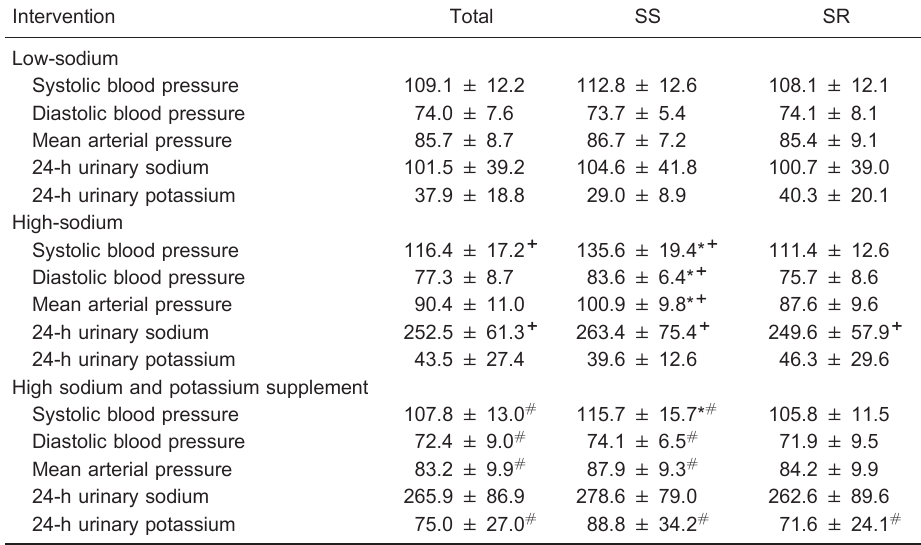
Table 2. Influence of dietary intervention on blood pressure levels (mmHg) and 24-h urinary sodium and potassium excretions (mmol/d).